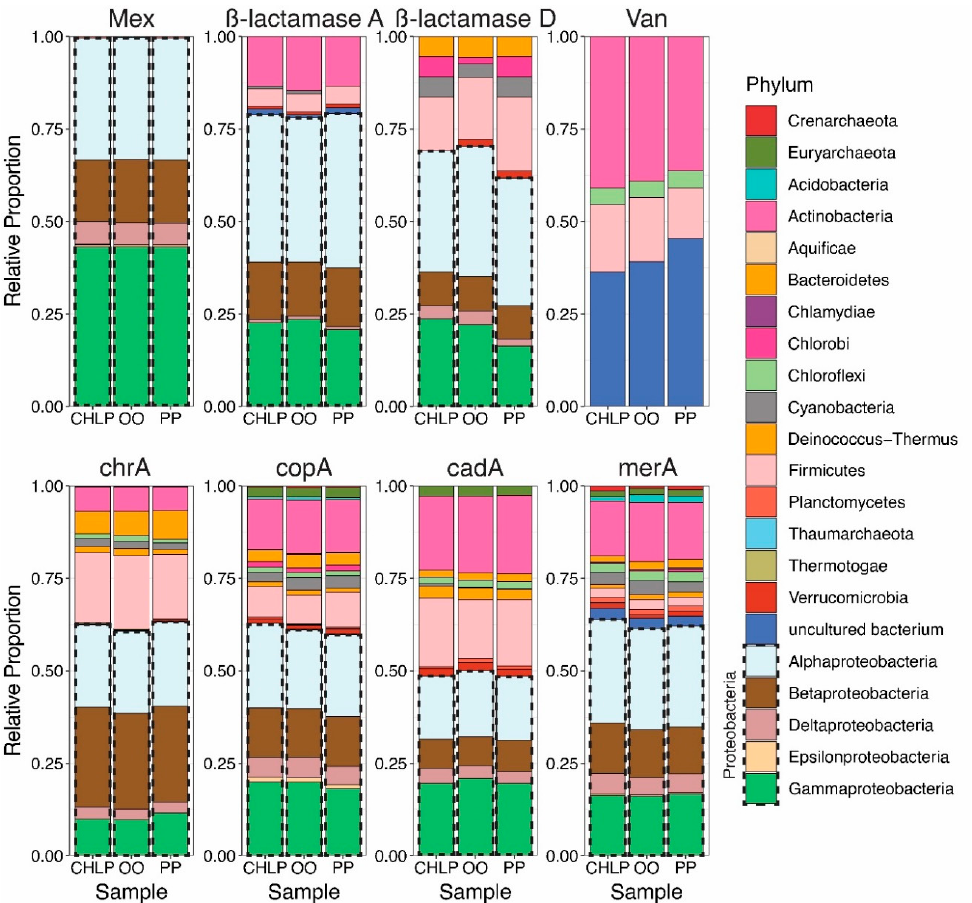
Figure 4. Relative proportion of the number of antibiotic resistance ( top row ) and metal homeostasis ( bottom row ) gene probes detected with lineages from designated phylum. The Proteobacteria are highlighted with the dashed lines but are further distinguished by their subphylum level.